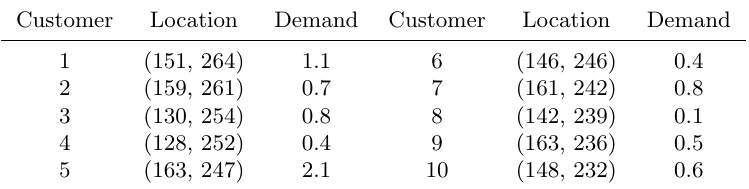
Table 1: Customer details for illustrative example.